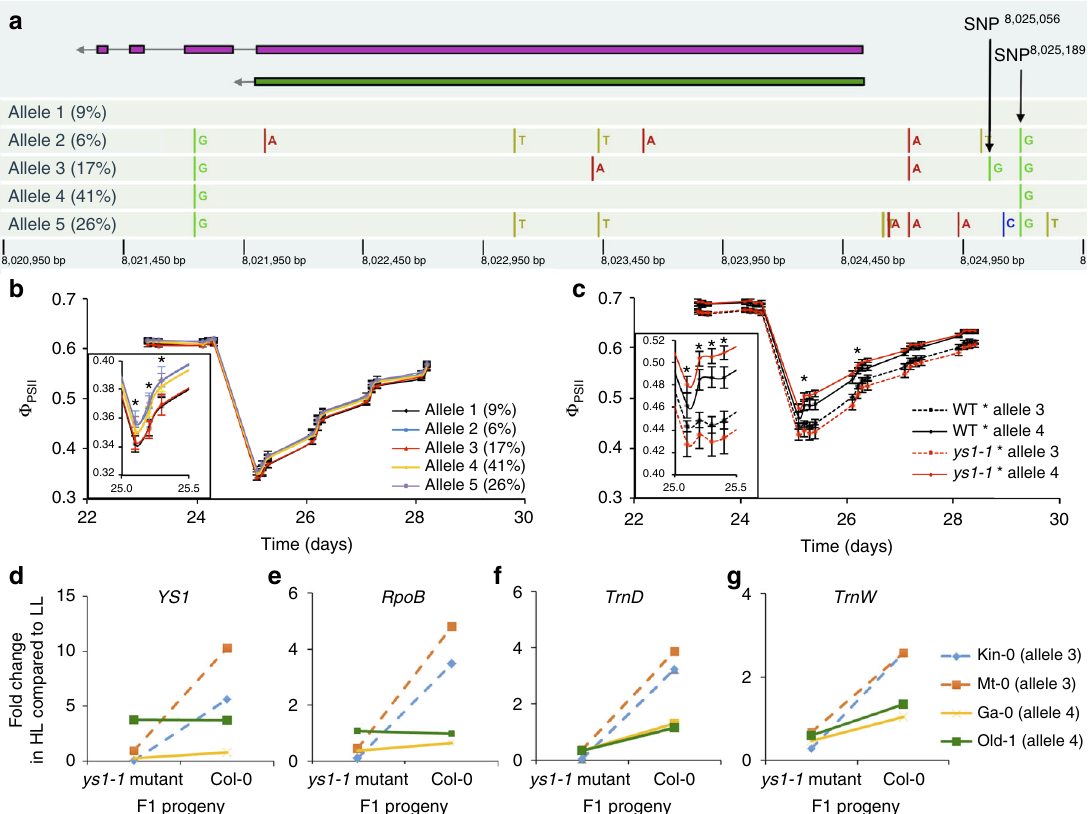
Fig. 4 Characterization of natural alleles of YS1 . a Schematic representation of the fi ve most abundant YS1 allelic haplotypes present in the GWAS panel and their frequencies (%) (www.arabidopsis.org). NB gene orientation is 3 ′ to 5 ′ as indicated with an arrow on the left; two splice variants are known (purple and green), exons are indicated with purple or green boxes and introns with lines connecting them. SNPs differing from the Col-0 reference genome sequence ( YS1 allele 1; YS1-1 ) are marked; two SNPs referred to in the text are indicated by arrows, chromosome 3 positions are indicated at the bottom (picture from http://signal.salk.edu/atg1001/3.0/gebrowser.php). b Average photosynthesis ef fi ciencies ( Ф PSII ) ( ± s.e.m.) of accessions carrying one of fi ve YS1 alleles before (LL) and after an increase in irradiance (HL), the inset shows small but signi fi cant differences (* p < 0.05, T -test series) between allelic groups. c Ф PSII ( ± s.e.m.; N = 16) of F1 progeny of crosses between Col-0 wild type (WT; YS1-1 ) or ys1-1 mutants with either Ll-0 carrying a YS1-3 allele, or Ga-0 carrying a YS1-4 allele, con fi rming that natural genetic variation at the YS1 gene explains the phenotypic variation identi fi ed by QTL23; * indicates a signi fi cant difference ( p < 0.05; T -test) in allelic effect on the Ф PSII difference at indicated time points between the different WT × accession and ys1 × accession F1 progenies. d – g Fold changes in mRNA expression of YS1 ( d ), RpoB encoding the β -subunit of the Plastid-Encoded Polymerase (PEP) protein ( e ), and the chloroplast-encoded tRNA genes TrnD ( f ) and TrnW ( g ), two transcriptional targets of PEP, transcription of which is affected by YS1 . Expression at HL is compared with expression at LL in F1 progeny of crosses between either Col-0 WT or the Col-0 ys1-1 mutant and natural accessions Kin-0 and Mt-0 (carrying the YS1-3 allele, dashed lines) or Ga-0 and Old-1 (carrying the YS1-4 allele, continuous